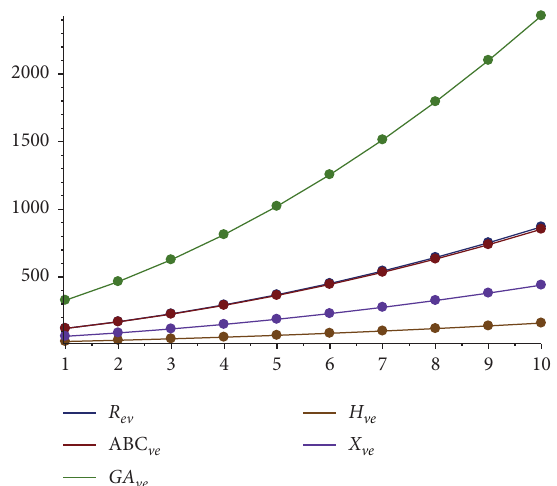
Figure 3: The graphical representation of R